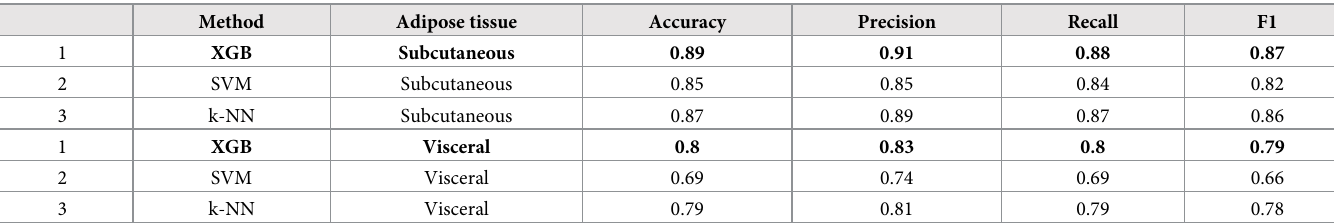
Table 1. Performance evaluation for predicting “inflammatory”, “metabolic” and “other” receptor types in subcutaneous and visceral adipose.